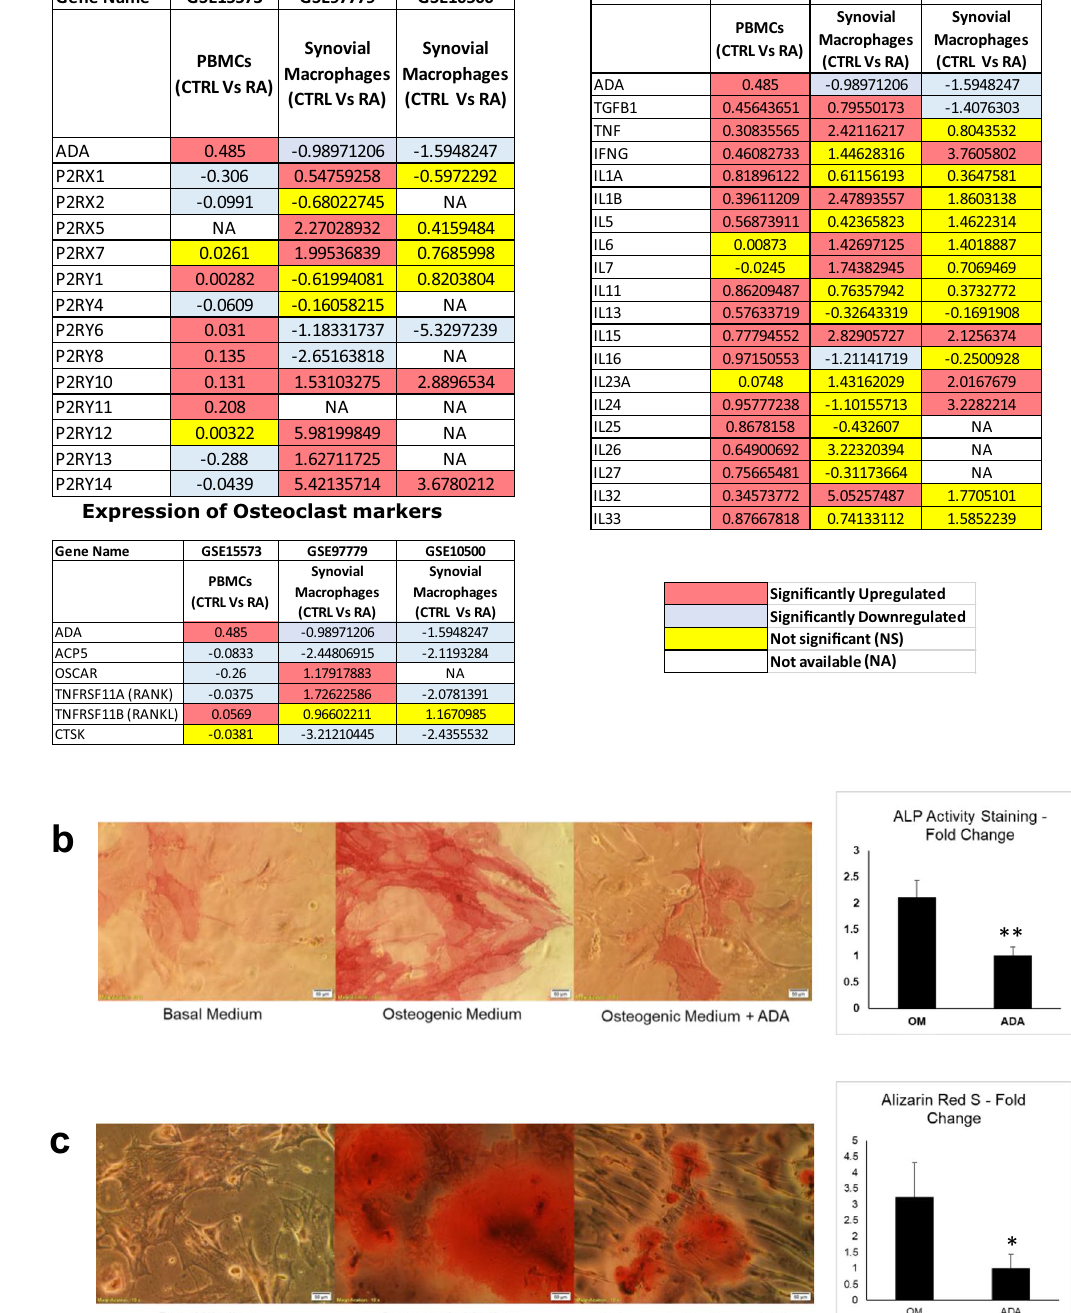
Figure 7. ( a ) Comparative transcriptomics data analysis of High and Low ADA expression datasets showing differential gene expression of P2 receptors, inflammatory cytokines and osteoclast markers in PBMCs and synovial macrophages respectively. ( b ) ADA treated MSCs in osteogenic medium showed significantly reduced differentiation to osteoblasts compared to those treated with osteogenic medium alone as evident from ALP staining (OM = Osteogenic Medium; ADA = Osteogenic medium with ADA). ( c ) Alizarin Red S staining shows reduced mineralization in osteoblasts differentiated from MSCs in the osteogenic medium with ADA compared to osteogenic medium alone (OM = Osteogenic Medium; ADA = Osteogenic medium with ADA). (showing *representing a p value of ≤ 0.05, and **representing a p value of ≤ 0.005). All the plots were made using Origin